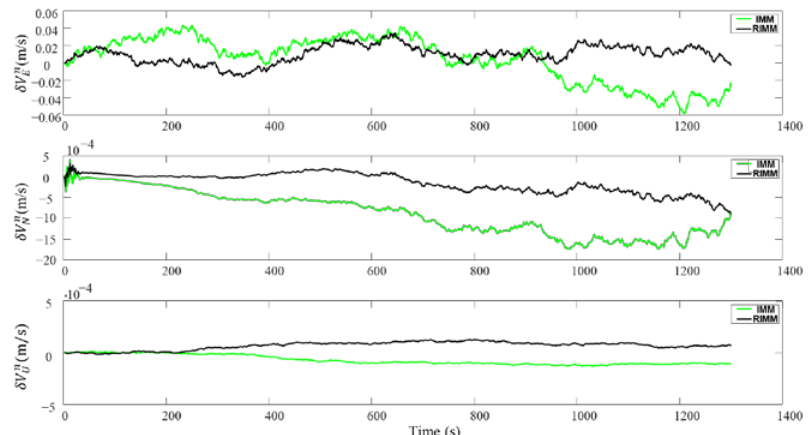
Figure 13. Velocity errors of RIMM and IMM.